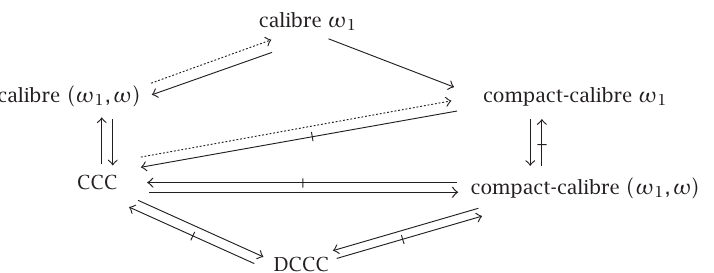
Figure 3.1 . Relative strengths of the conditions for linearly-ordered and for monotonically normal